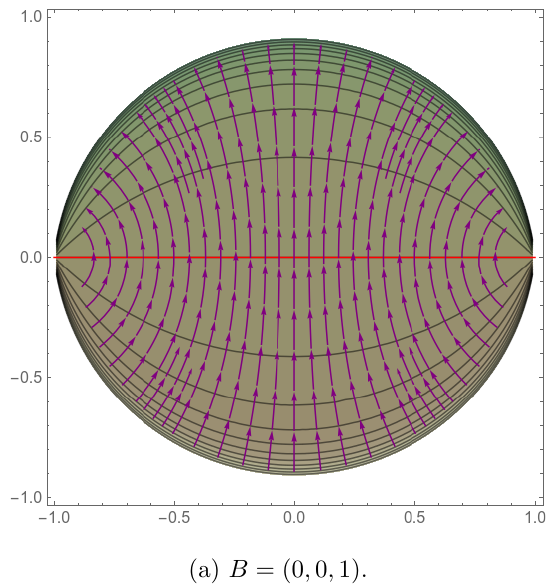
Figure 5. Contour plot of the degenerate spacelike Hesse function (cid:3) 0 ; 0 ; 1 , where the gradient (cid:13)ow of (cid:3) is indicated by purple arrows. The values of (cid:3) decrease from lightest brown to darkest green. The vanishing locus of (cid:3) is the horizontal segment shown in red. The level sets are hypercycles with axis given by the vanishing locus.